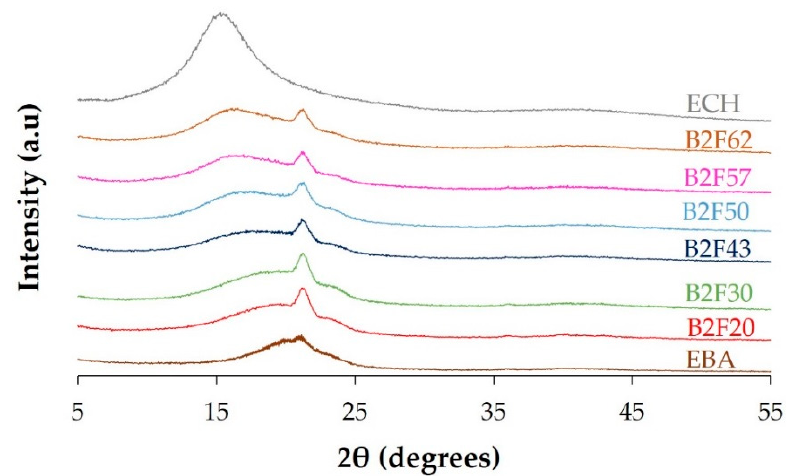
Figure 5. X-ray diffractograms of the EBA copolymer, the ECH resin and their binary blends.